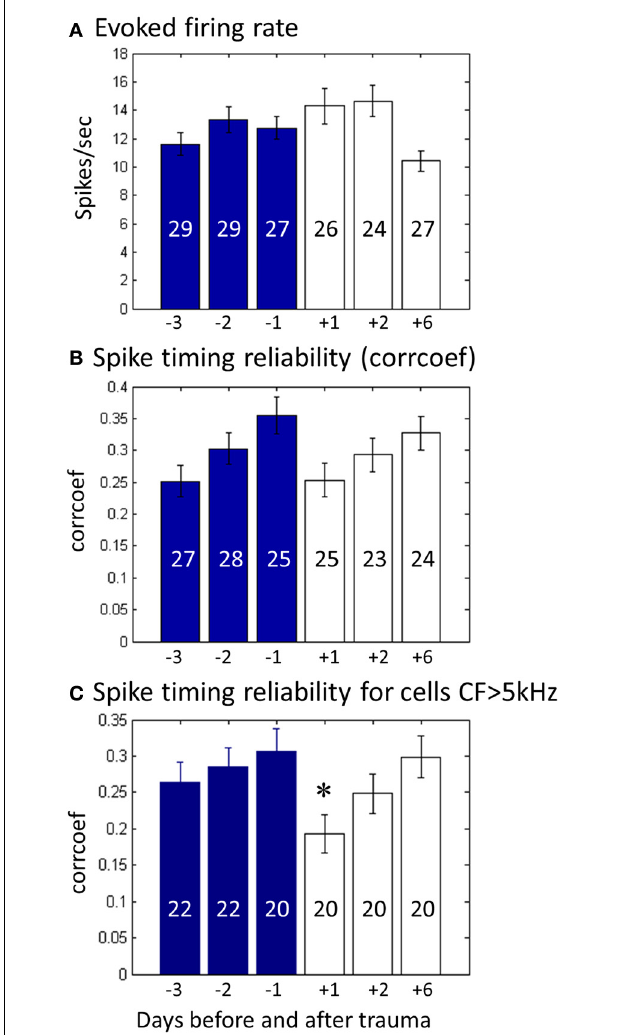
FIGURE 6 | Impact of hearing loss on the responses to vocalizations. (A) Histogram of the average firing rate during the first 90ms of the responses to the different vocalizations from 3 days before trauma (blue) to 3 days after (white).Thenumberofneuronsineachrecordingdayisindicatedwithineach bar. (B) Same for the spike timing reliability as computed from the CorrCoef (see Methods) for all recorded neurons. The CorrCoef is an index of the trial-to-trial reliability of the response. (C) Same as (B) , but only for neurons which CF is above the trauma frequency (CF > 5kHz). Stars correspond to statistically significant difference ( p < 0 . 05) from control level at